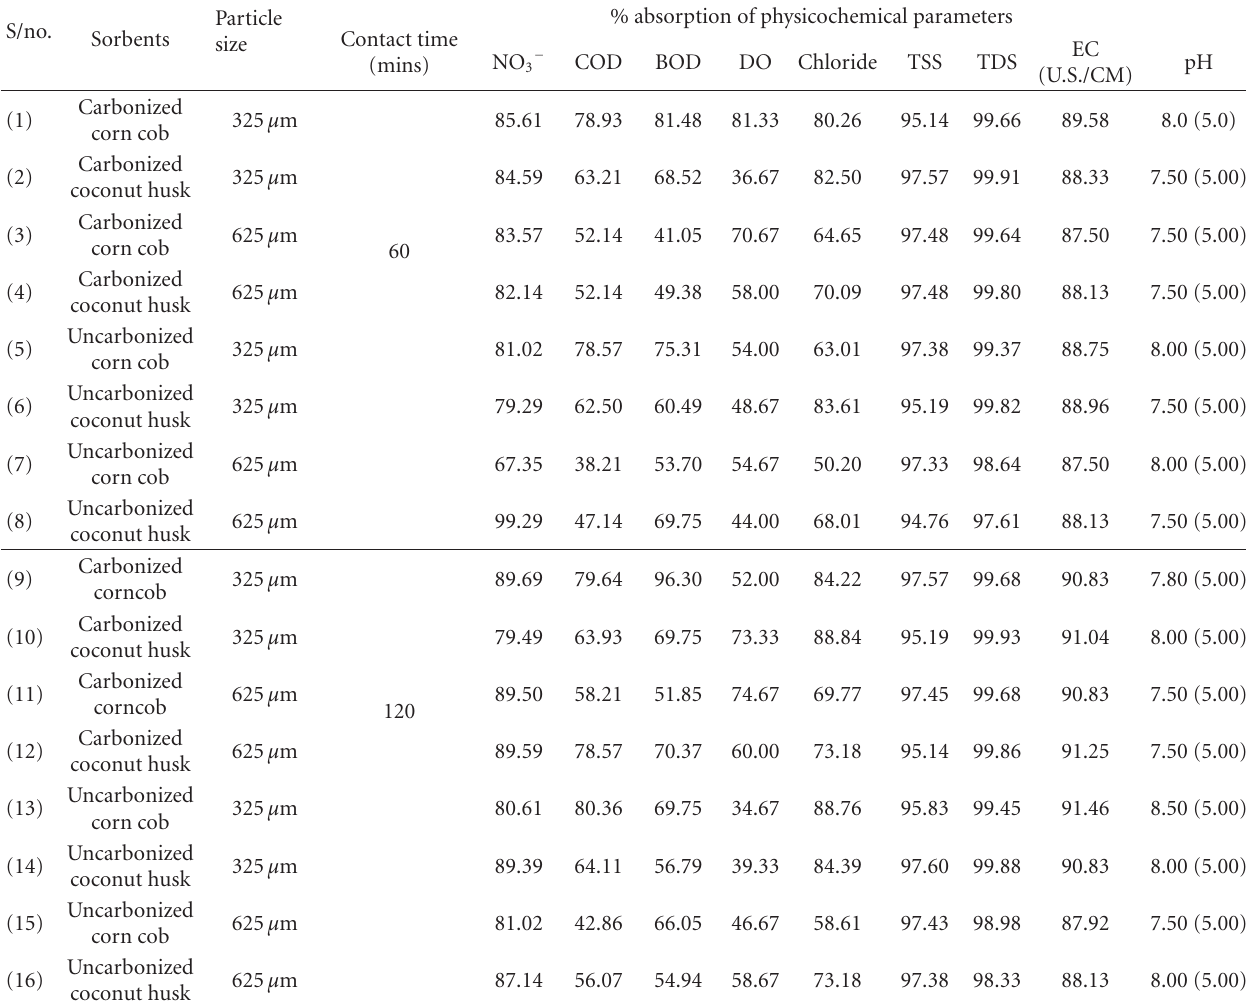
Table 2: Use of carbonized/uncarbonized waste cellulosic sorbents in removal of pollutants from wastewater.